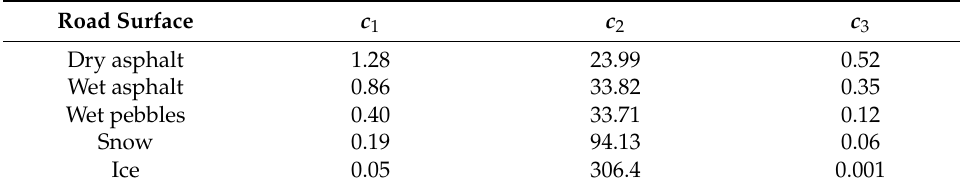
Table 1. Parameters of road surface adhesion coefficient